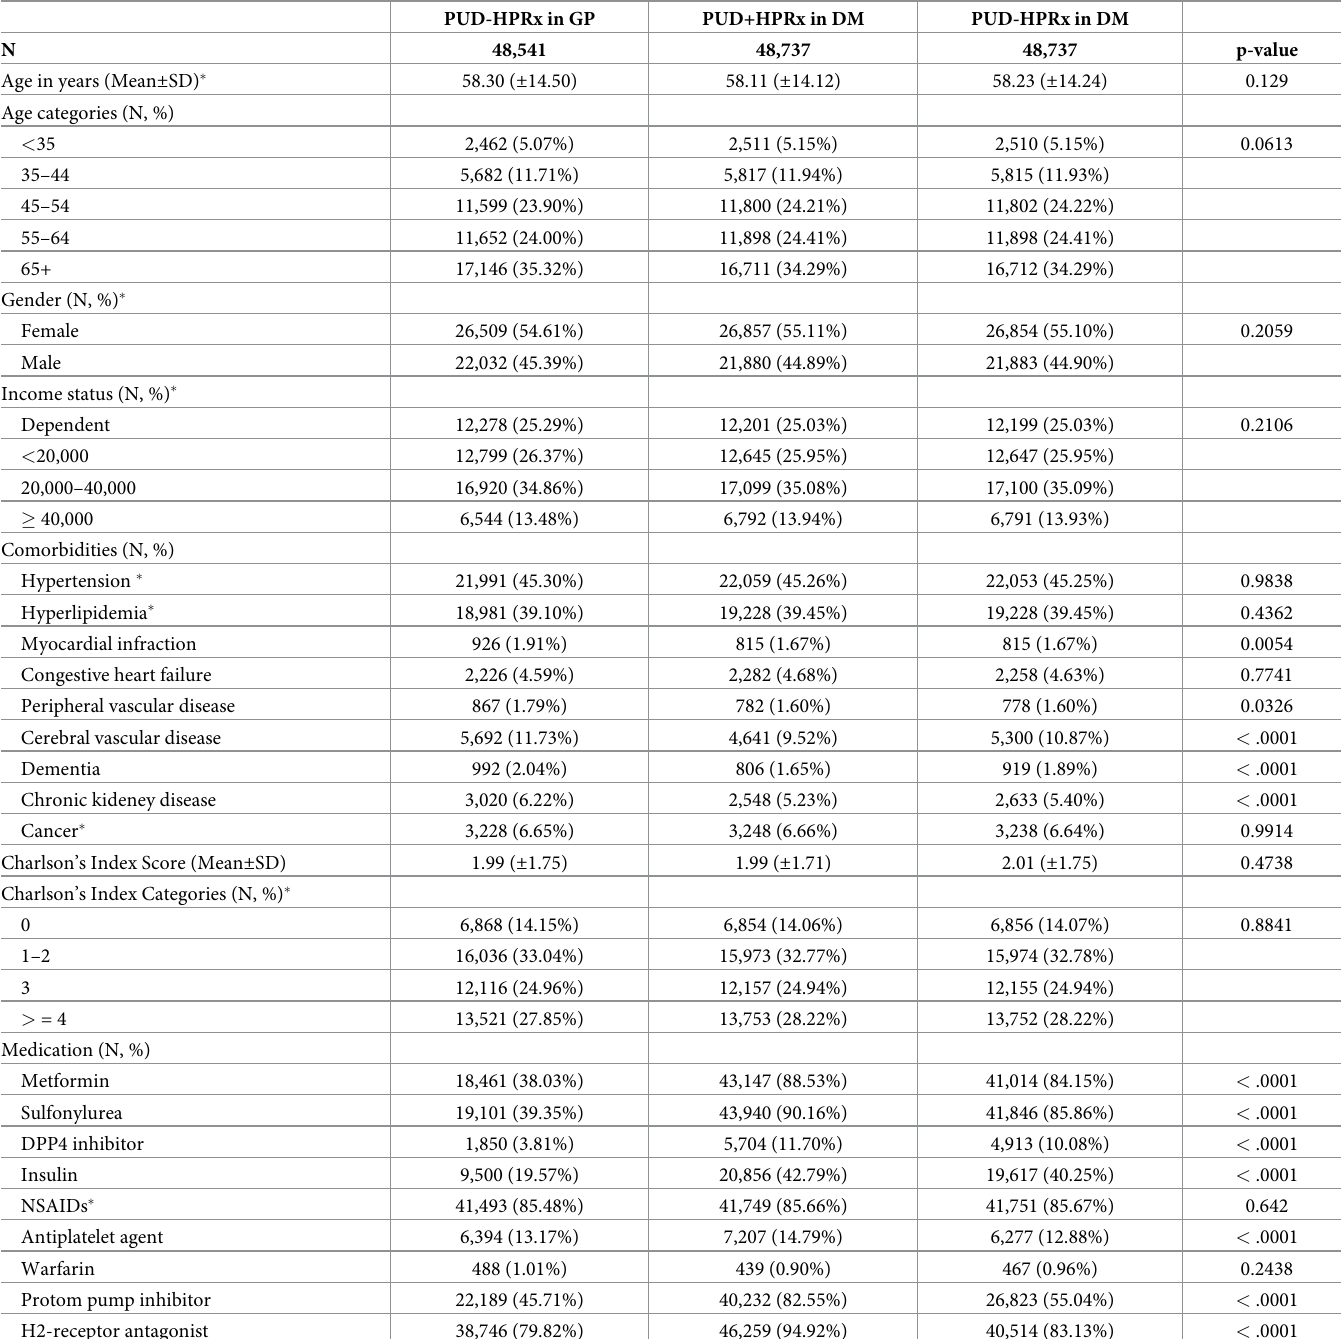
Table 1. Demographic data of PUD+HPRx and PUD-HPRx in DM and general population post-propensity